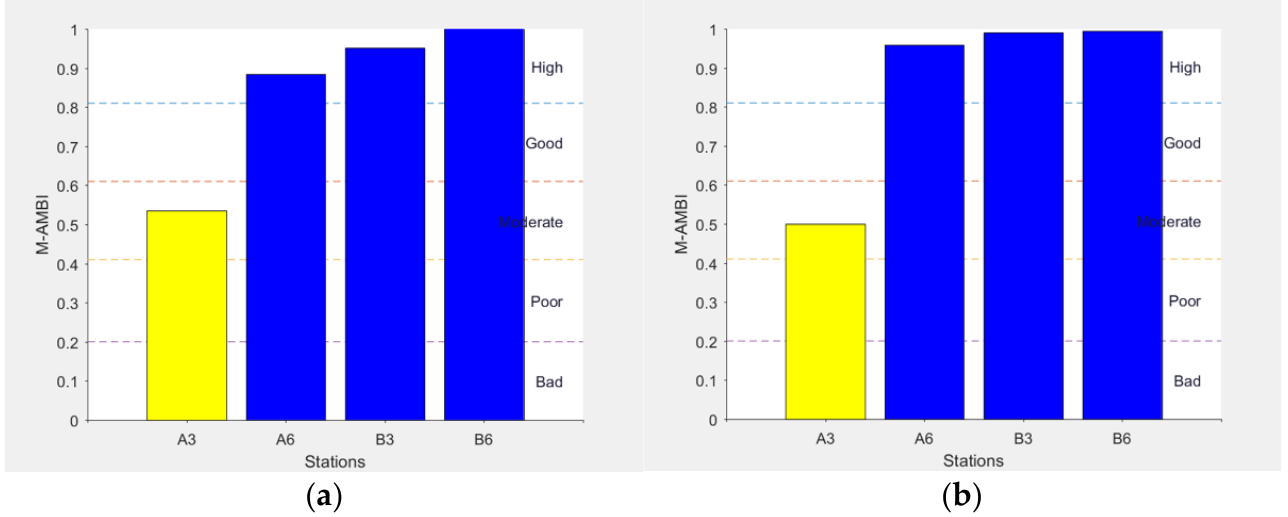
Figure 7. M-AMBI values and respective ecological status relative to the 4 examined sites in February ( a ) and July ( b ) (modified from [28] with permission from IEEE, 2022, Copyright Clearance Center’s RightsLink ® ).